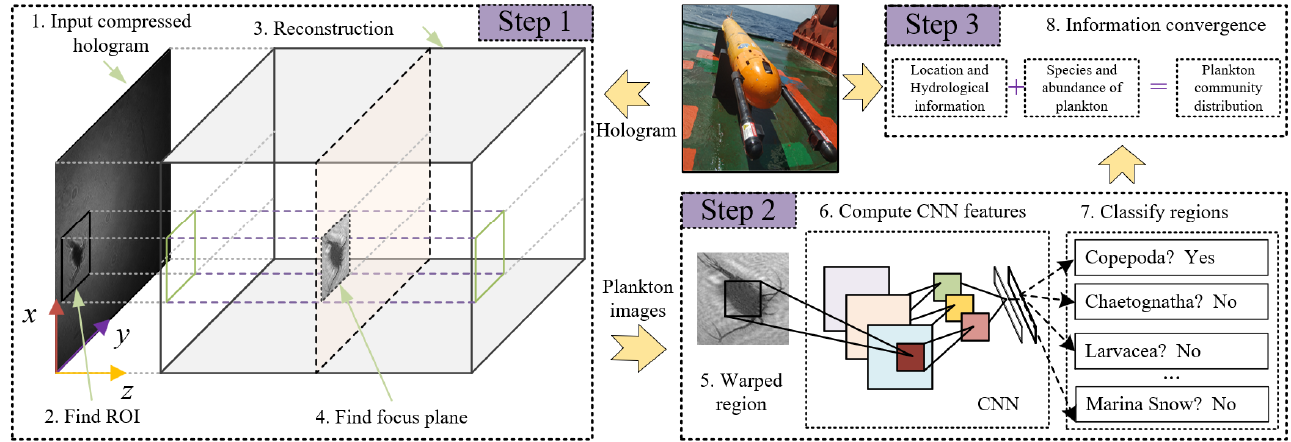
Figure 5. Flowchart of the data processing algorithm for the DHUG’s estimation of plankton biomass.